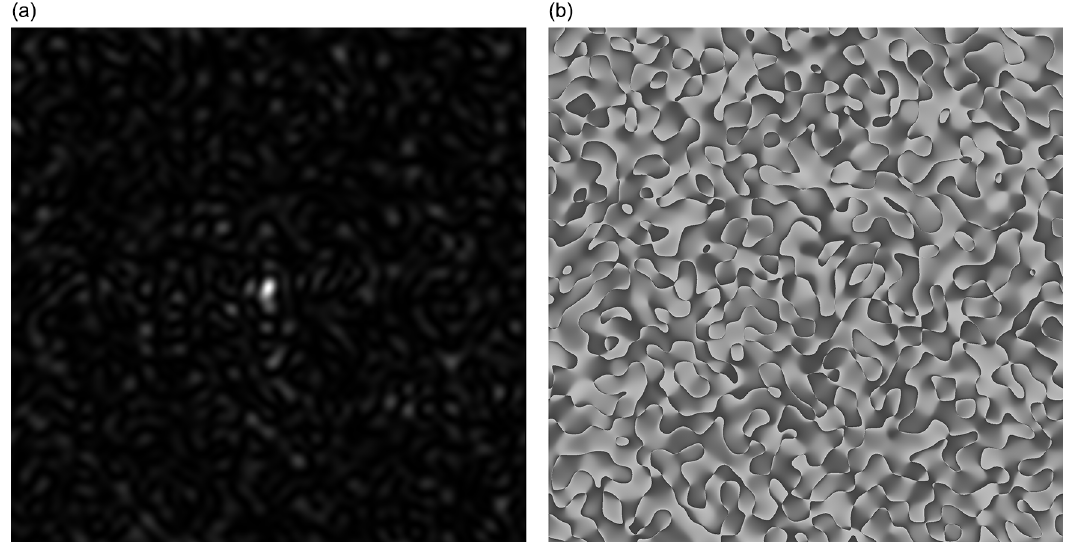
Figure 1. GB-speckles, generated for genes #1, #2 and #3: (a) Speckle pattern for 2D intensity distribution, (b) Speckle pattern for 2D phase